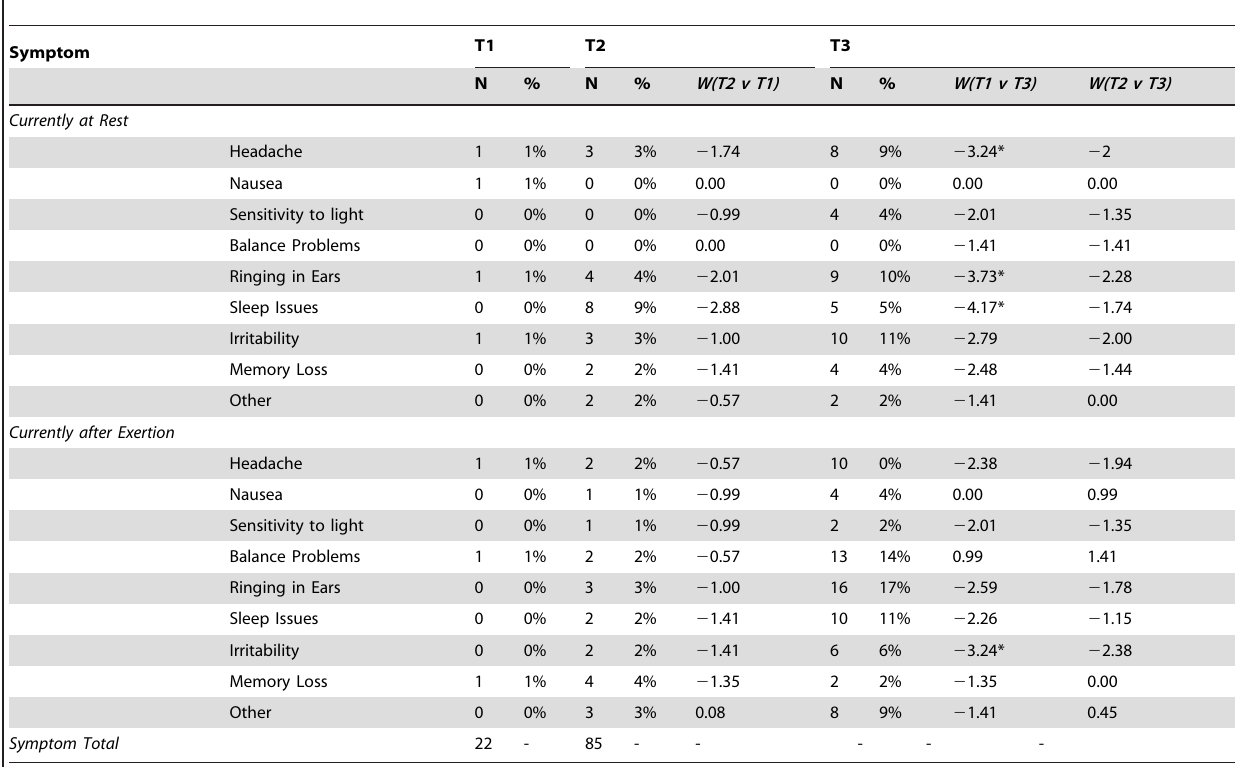
Table 2. ANAM4 TBI-MIL Questionnaire and ACSI Symptomology for Non-Concussed Service Members (N=93).